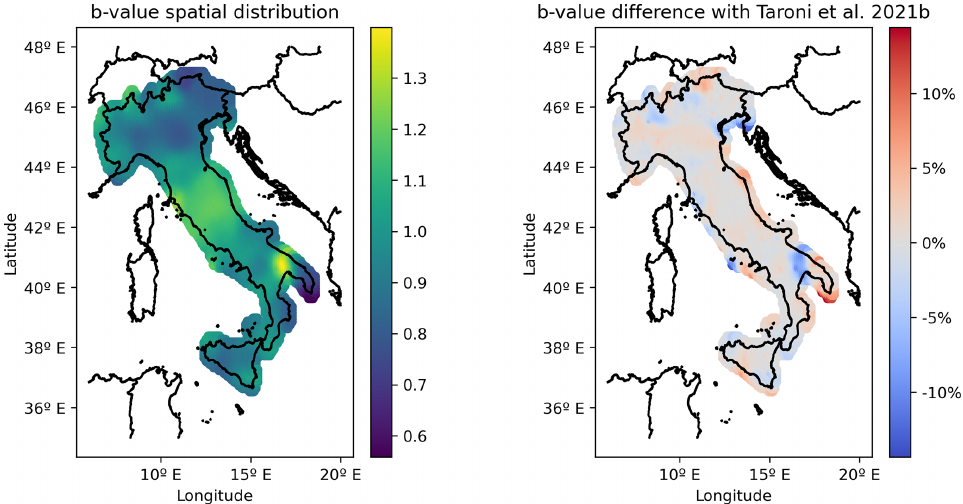
Figure 7. Spatial distribution of the b -values obtained in this work (left) and the percentage change of these with the b -values from Taroni et al. (2021b) (right). 56309 events have been used in the b -value calculation.